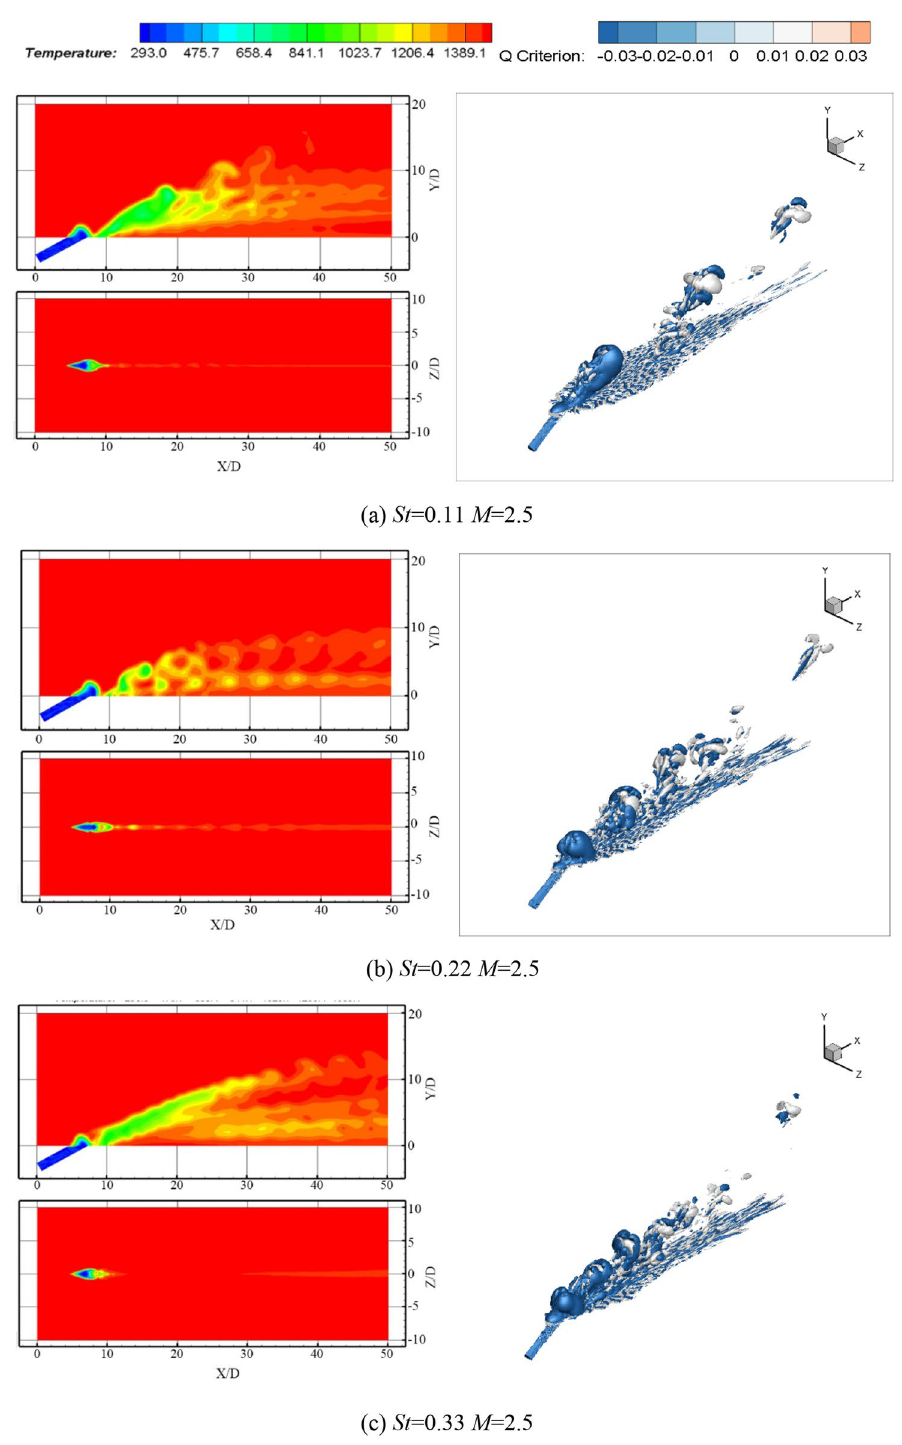
Figure 6. Temperature contours and comparison of average film cooling effectiveness when a synthetic coolant is ejected at different Strouhal numbers with fan-shaped hole and M =